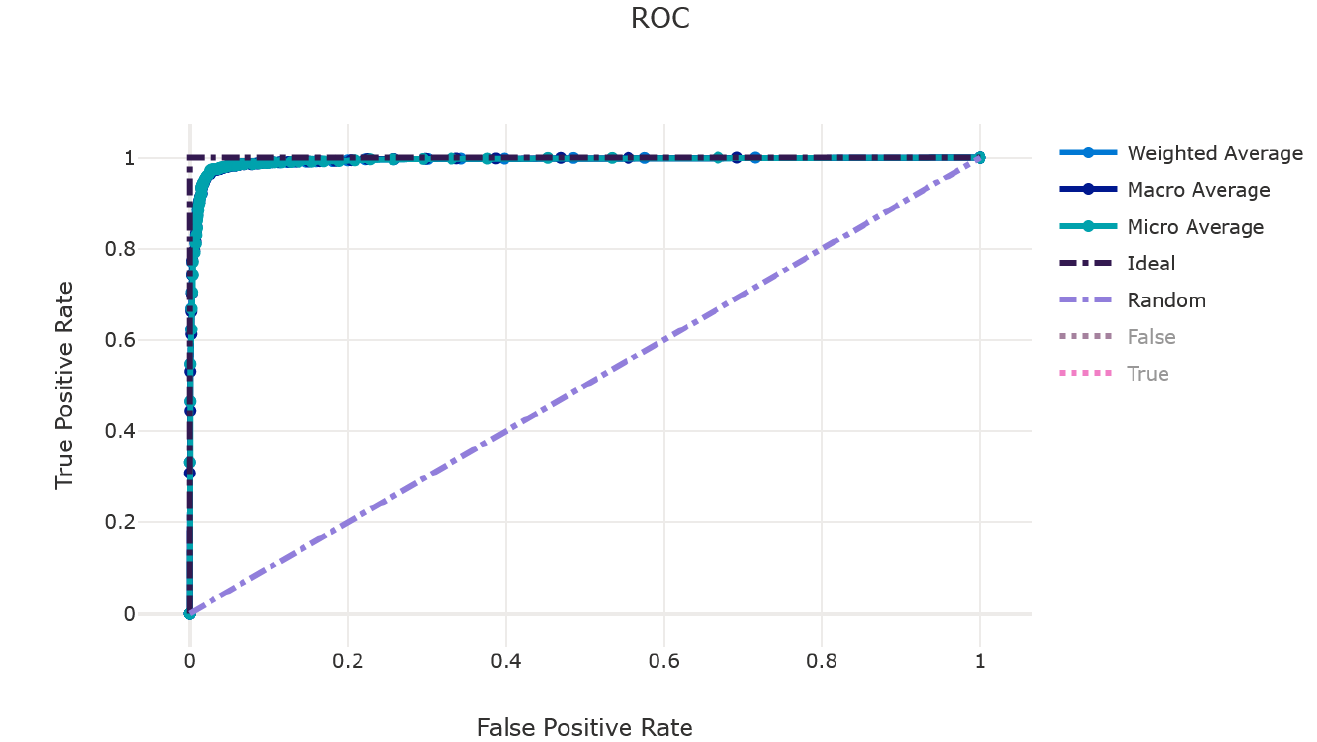
Figure 6. Receiver operating characteristic (ROC) curve. Figure 7 describes the graph with the results of the recall versus precision.